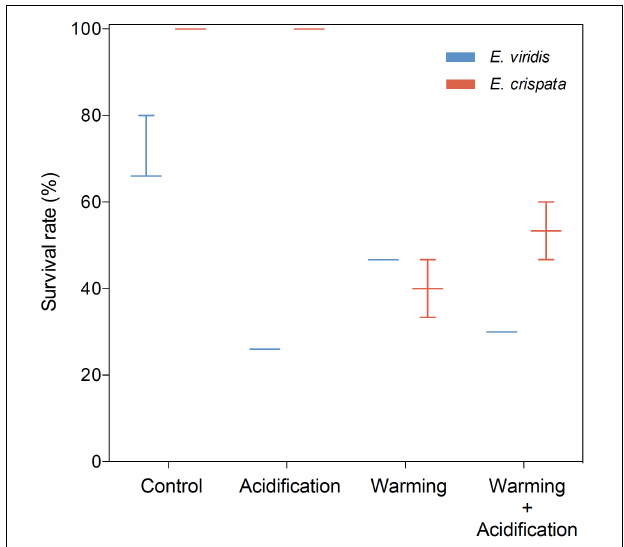
FIGURE 1 | Effects of ocean warming and acidification on survival (%) of tropical E. crispata and temperate E. viridis species, under different climate change scenarios, i.e., control (18 and 26 ◦ C, pH8.0); acidification (18 and 26 ◦ C, pH7.6); warming (22 and 30 ◦ C, pH8.0) and acidification + warming (22 and 30 ◦ C, pH7.6) experimental treatments. Tukey box-plots show median, percentile 25th and 75th, and –1.5 times interquartile distance (IQR) and +1.5 times IQR,